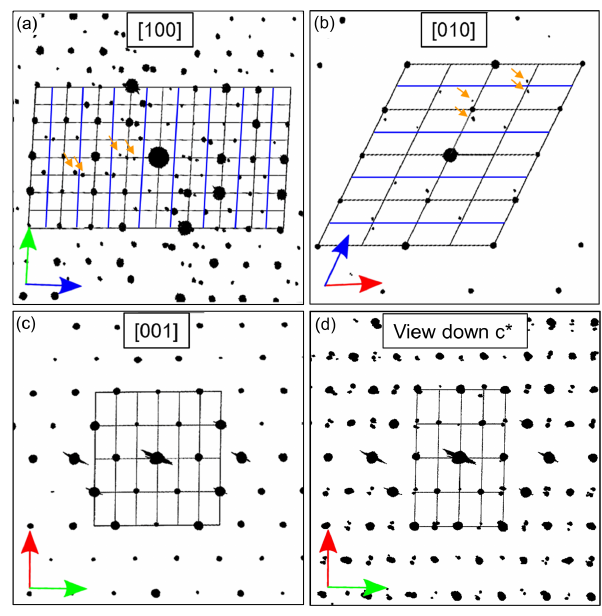
Figure 11. Cut of three main zones and projection of the re- constructed ADT diffraction volume (unit cell of labradorite indi- cated with black lines, arrows in red = a ∗ axis, green = b ∗ axis and blue = c ∗ axis, and blue lines indicate c -axis doubling). (a) [100], (b) [010], (c) [001] direction. (d) Projection of the reciprocal space along c ∗ showing C -centering and satellite reflections. In (a) and (b) satellite reflections are indicated by orange